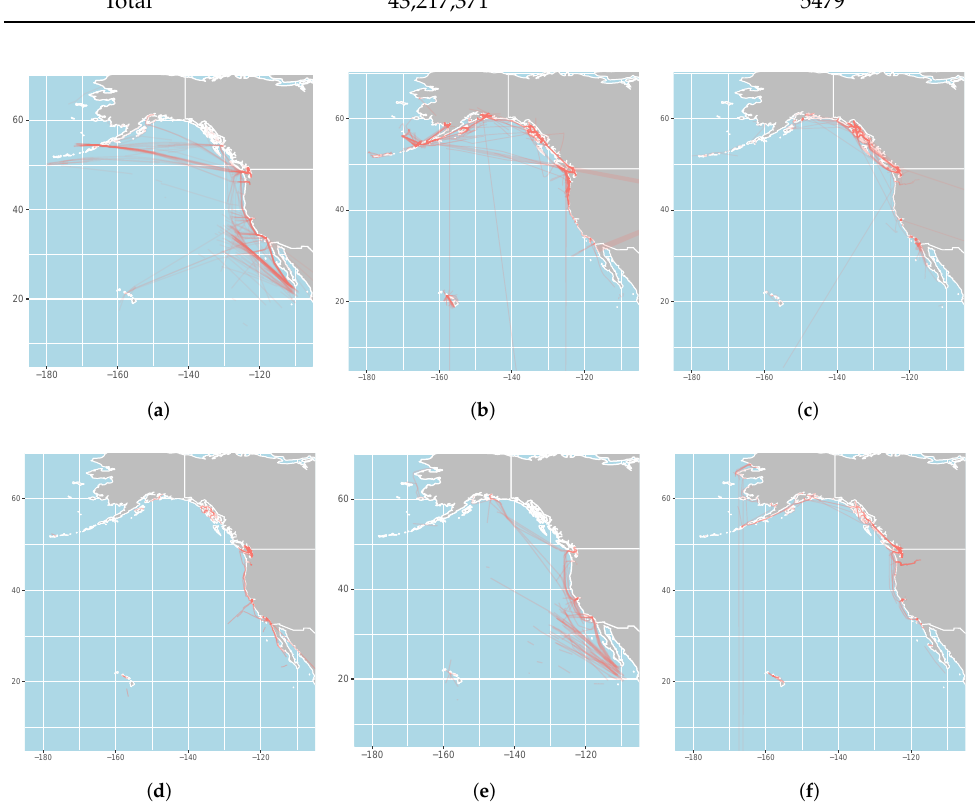
Figure 1. The trajectories that were contained in the raw data according to class, as portrayed on their respective regions (note the invalid/glitchy trajectories that were later removed): ( a ) cargo ships; ( b ) fishing ships; ( c ) passenger ships; ( d ) sailing ships; ( e ) tankers; ( f ) towing